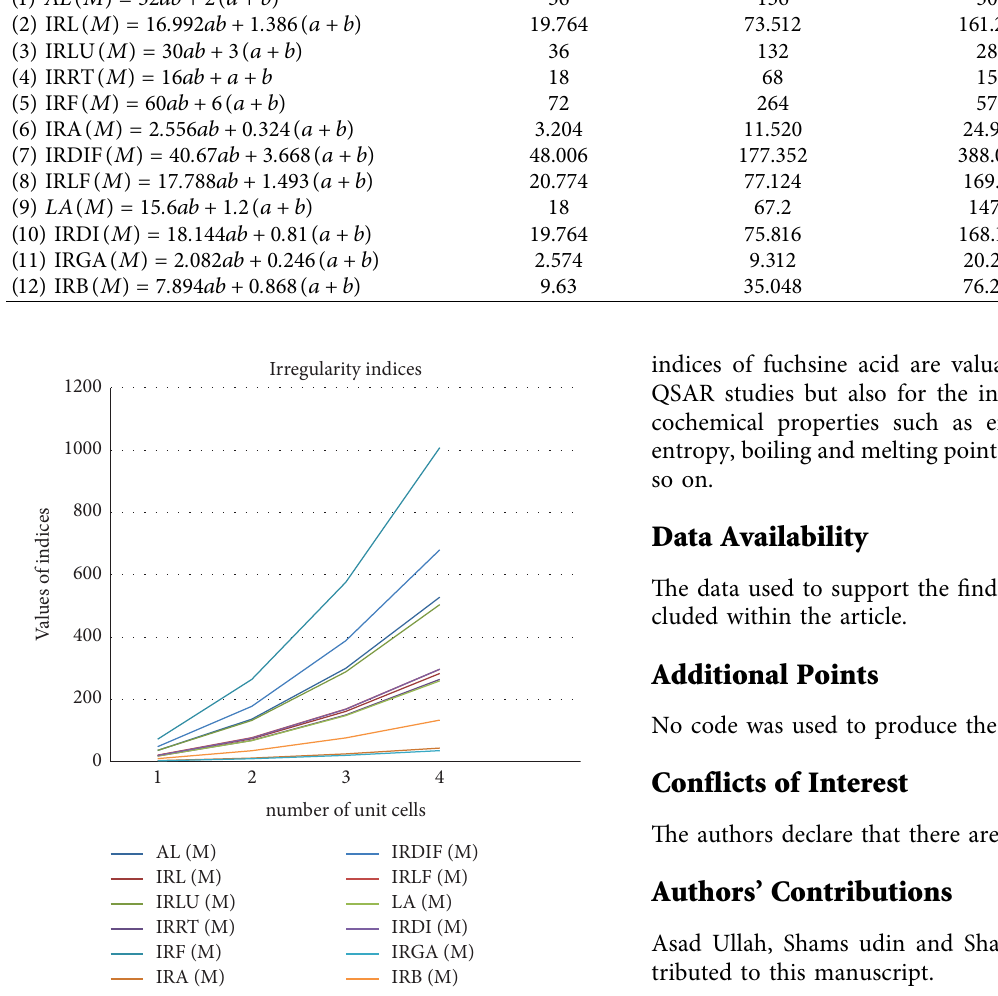
Irregularity indices